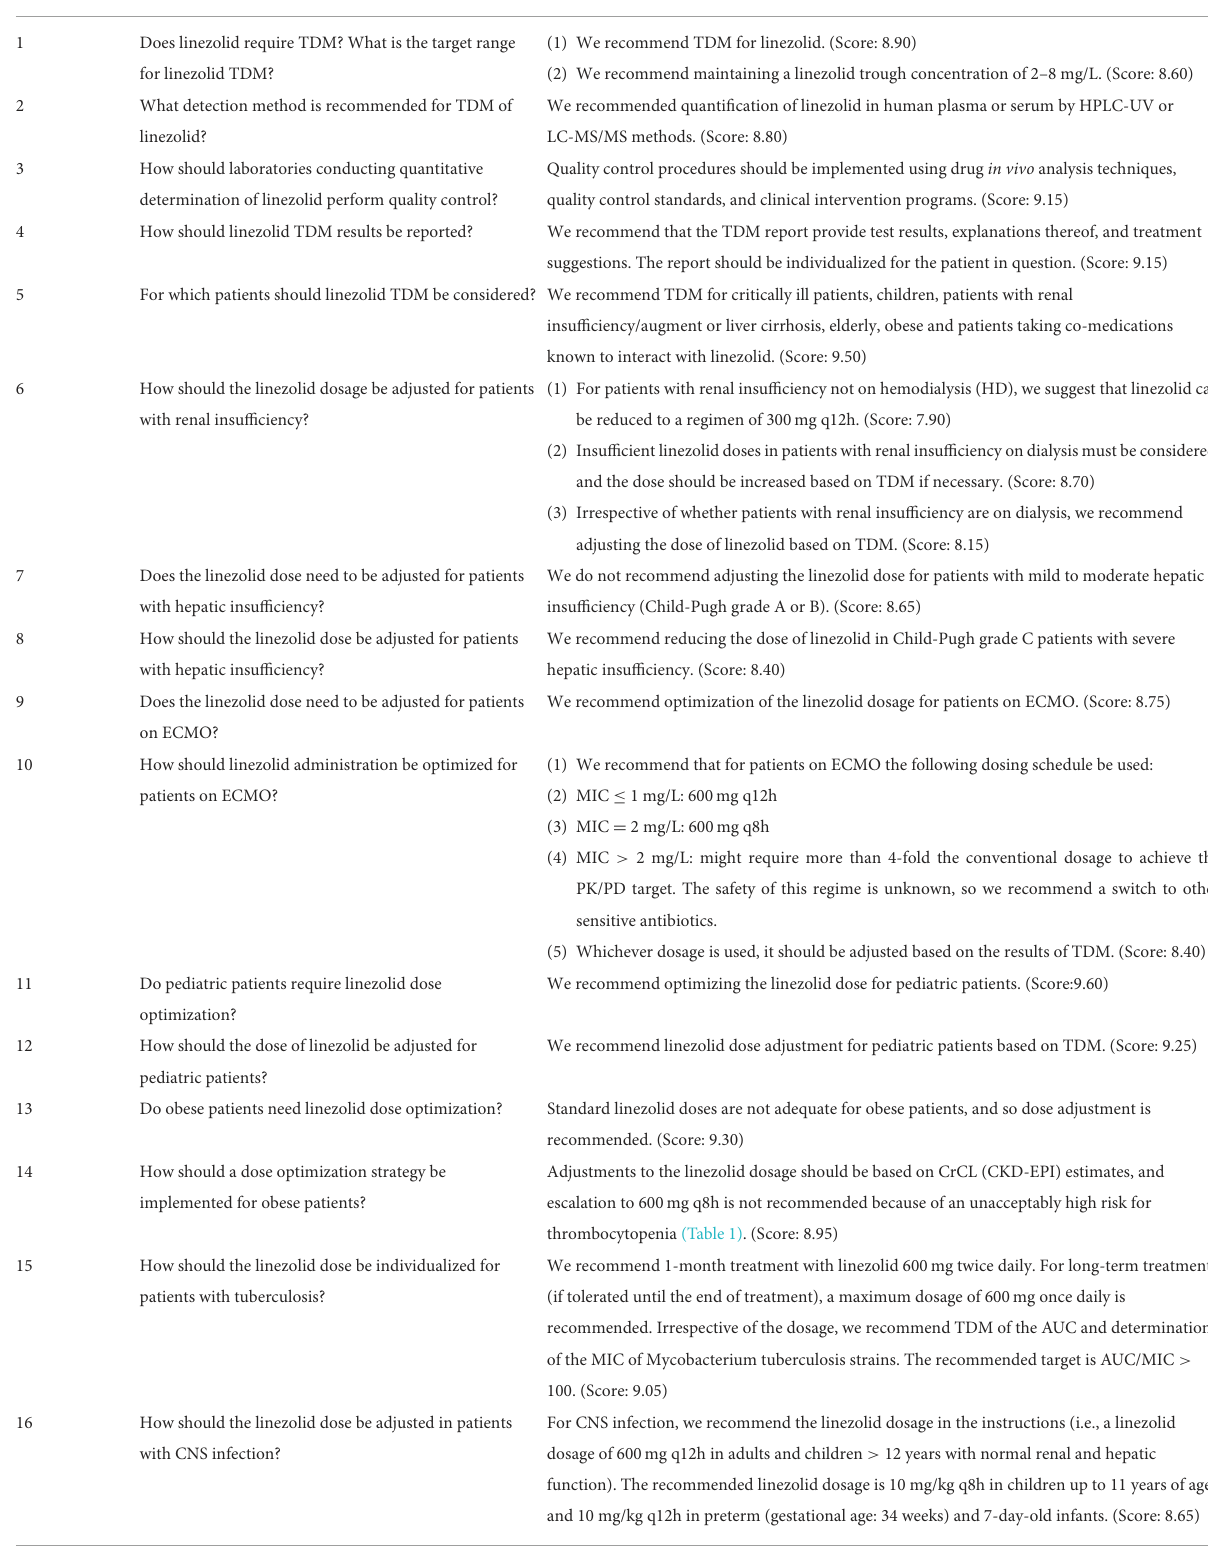
TABLE 2 Overview of expert consensus and summary of